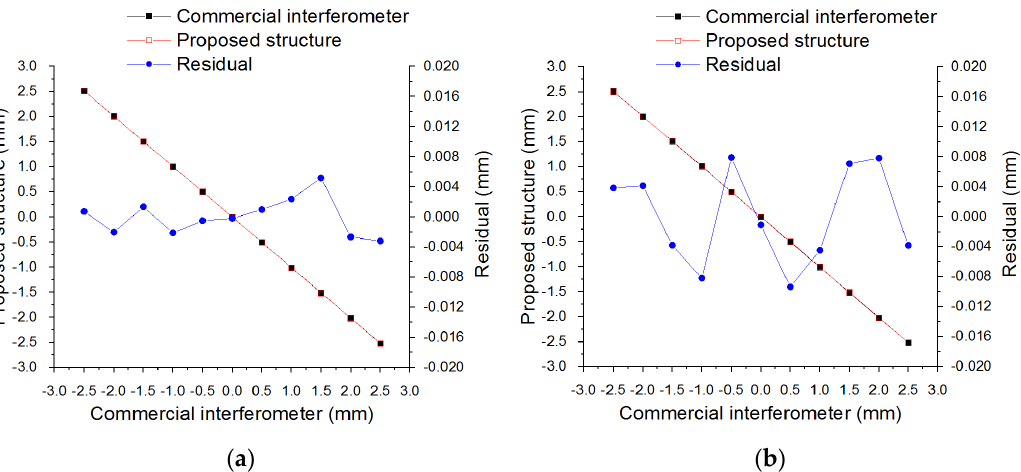
Figure 9. Calibration test of two-dimensional PSD (2D-PSD) in two directions: ( a ) X direction and ( b ) Y direction.